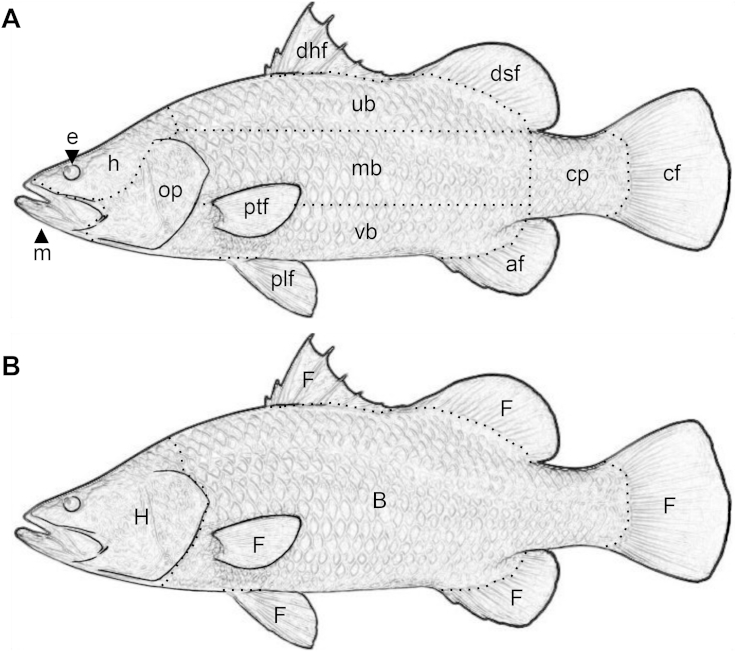
Lates calcarifer microhabitat terminology (A) and body surface regions (B) used for statistical analysis. af = anal fin; cf = caudal fin; cp = caudal peduncle; dhf = dorsal hard fin; dsf = dorsal soft fin; e = eye; h = head; m = mandible; mb = middle body; op = operculum; plf = pelvic fin; ptf = pectoral fin; ub = upper body; vb = ventral body. B = body; F = fins; H = head. Terminology is based on Helfman et al. (2009) and Roberts and Ellis (2012).